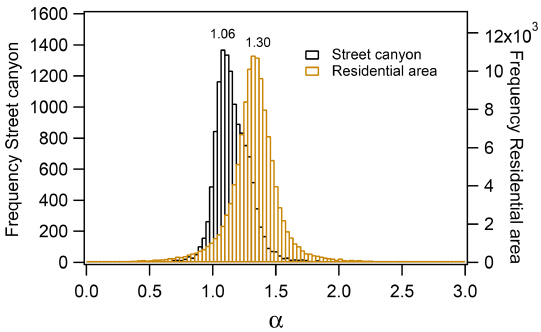
Figure 6. Absorption Ångström exponents calculated for the street canyon and residential area data. Histograms are for 1min resolu- tion